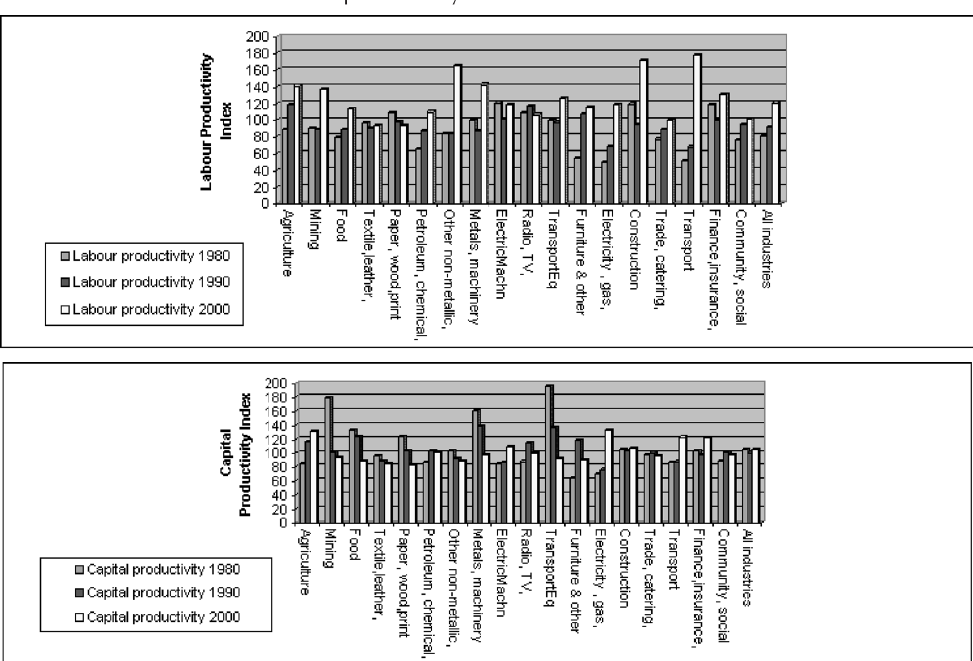
Factor productivity in South African sectors